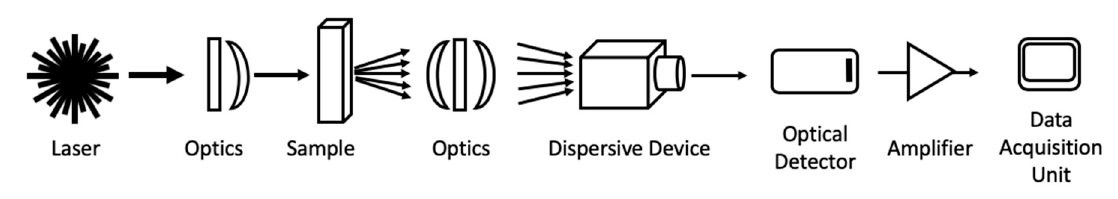
Figure 1. A schematic Raman spectroscopic system.